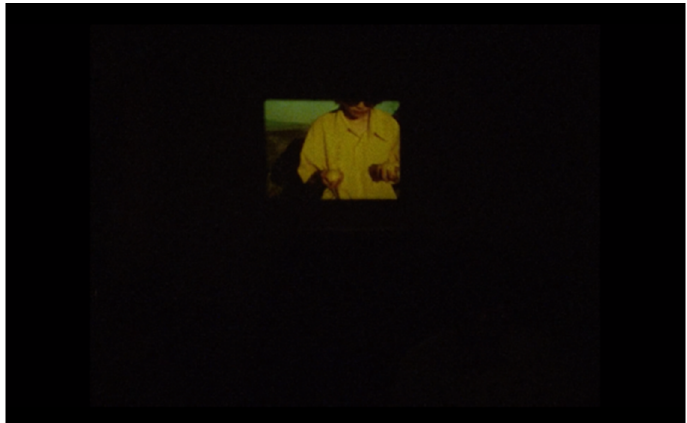
Figure 9. Words, Planets (2018).